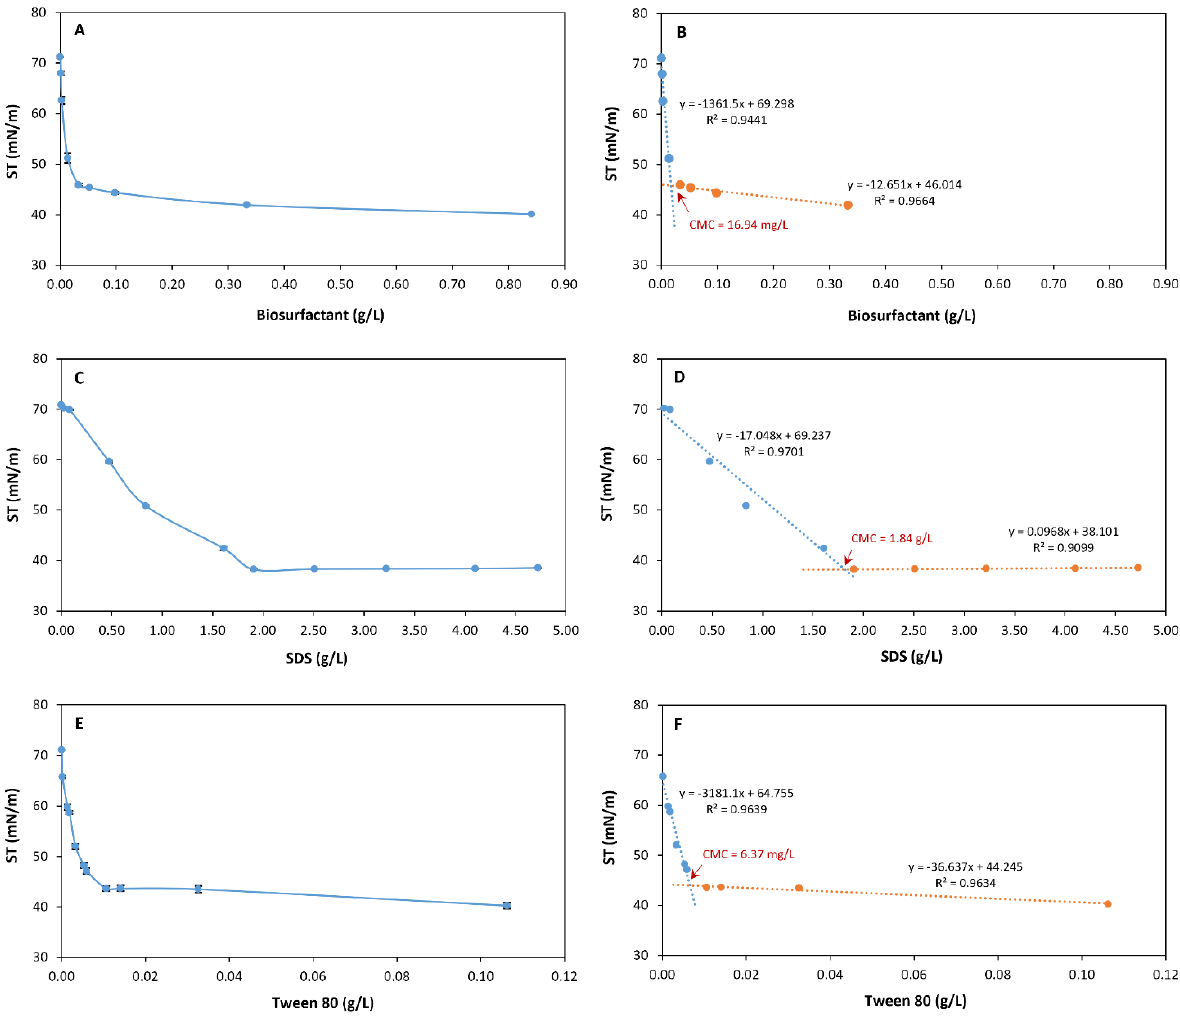
Figure 5. Evaluation of the surface tension (ST) of different solutions containing increasing surfactant concentrations: ( A ) Crude BS/BE; ( C ) SDS and ( E ) Tween 80, and calculation of the corresponding CMC ( B , D , F ). In all plots, each data point, for each concentration, is the average value of 10 measurements. Standard deviation ( n = 10) is represented as error bars in plots ( A , C , E ).